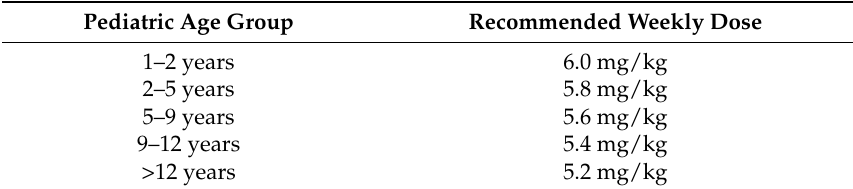
Table 4. Asunercept dose recommendations for pediatric patients.